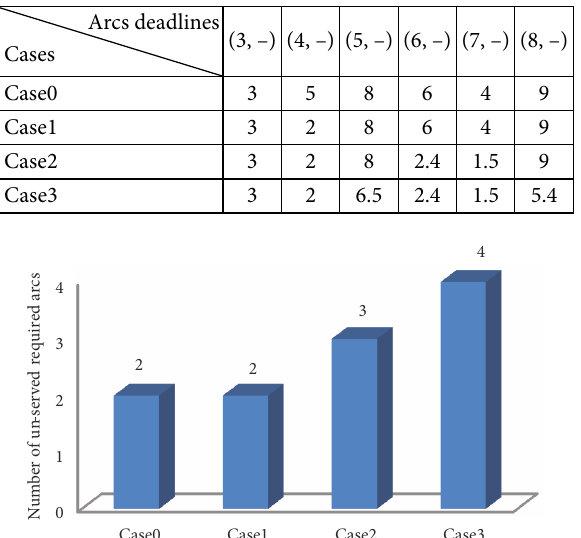
Figure 9. Effects of the tighter the deadlines on number of un-served required arcs